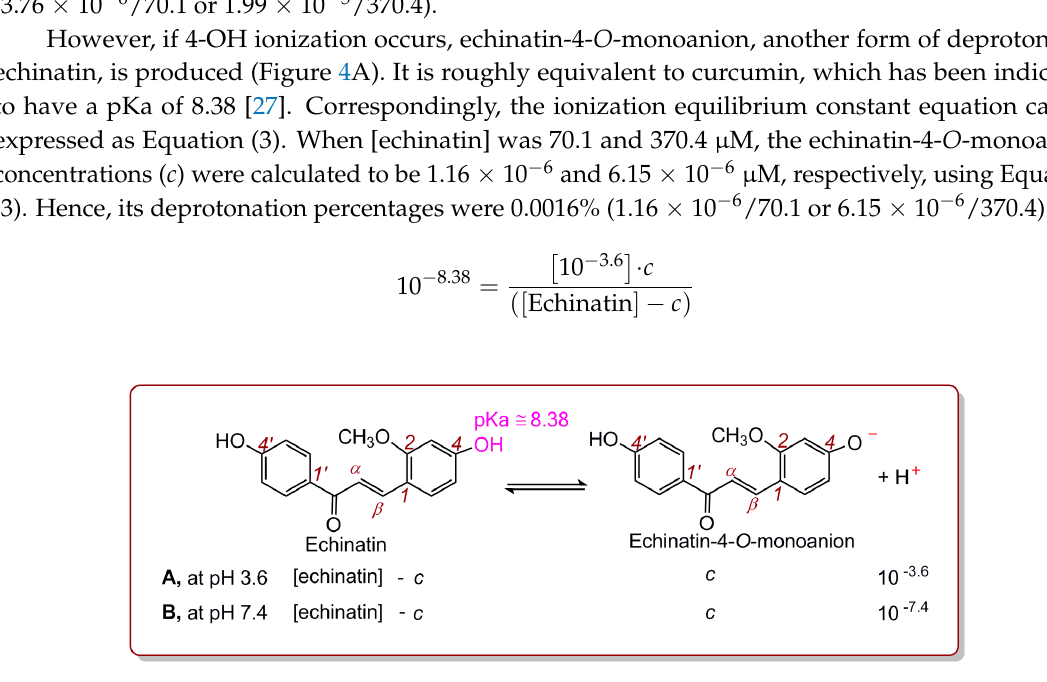
Figure 3. Ionization equilibrium of the 4 ′ -OH group in echinatin at pH 3.6 (A) and 7.4 (B).